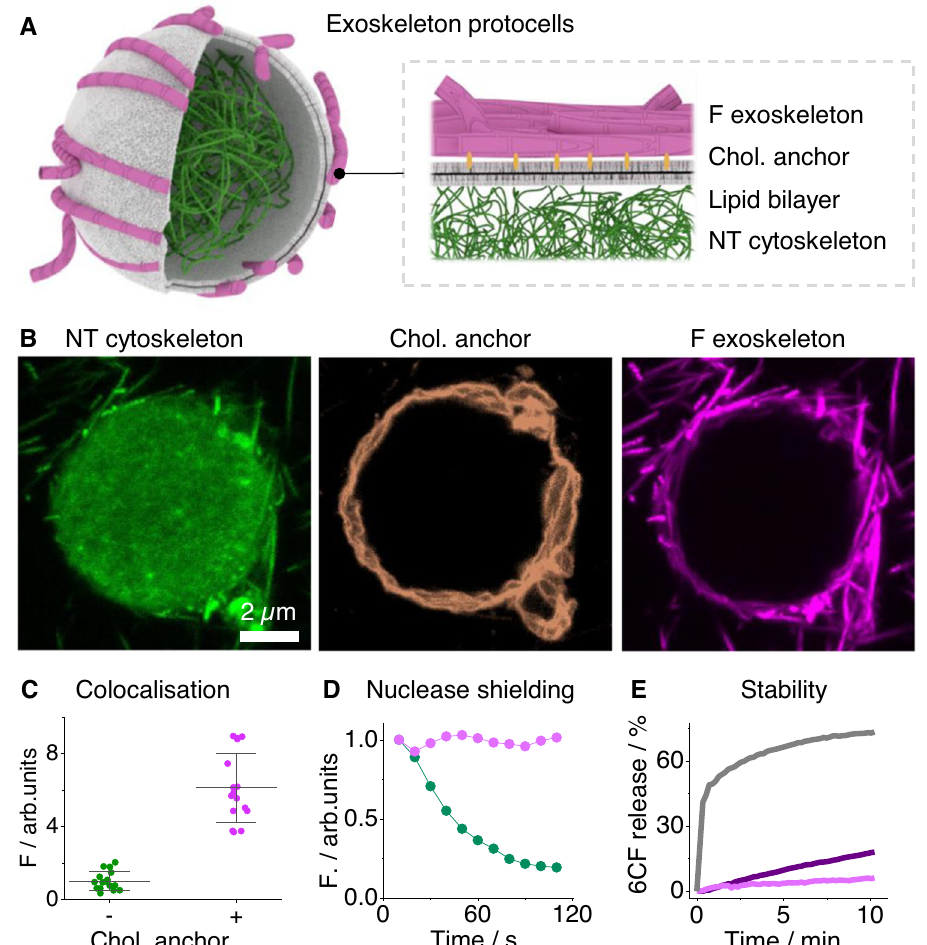
Fig. 4 | Constructing exoskeleton protocells. A Schematic representation. B CLSM images of exoskeleton protocell, nanotube (NT) cytoskeleton (green channel),cholesterollipidanchors(orangechannel)andhairy fi ber(F)exoskeleton (magenta channel), scale bar 2 µ m. C Dot plot of fi ber exoskeleton fl uorescence bound to GUVs either without ( − ) or with (+) cholesterol lipid anchors. Line and error bars represent the mean and standard deviation, respectively. D CLSM-